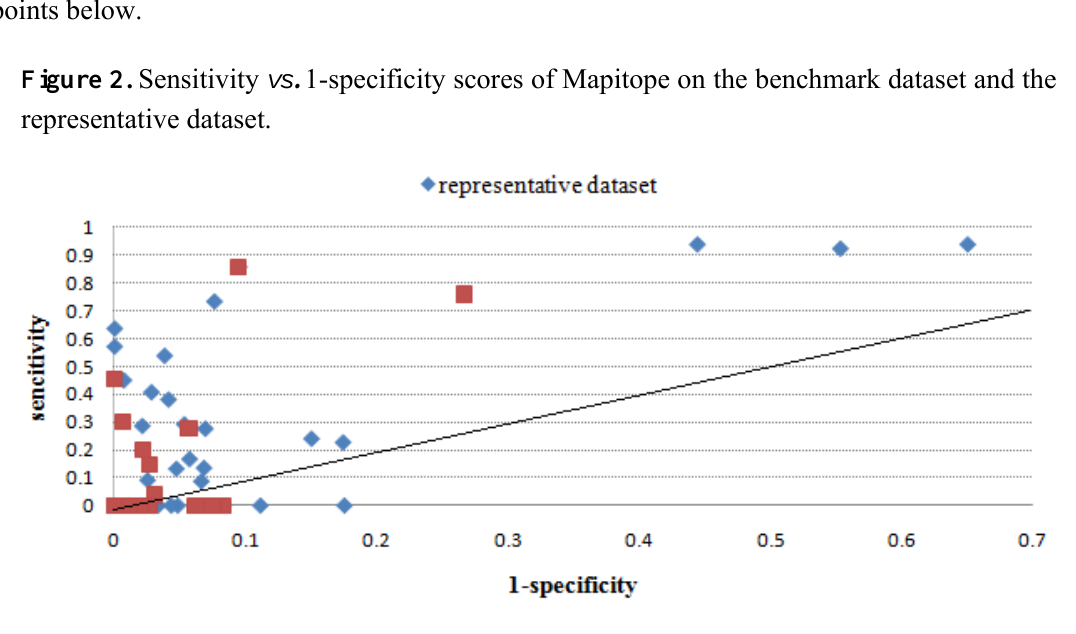
Figure 3. Sensitivity vs. 1-specificity scores of PepSurf on the benchmark dataset and the represendative